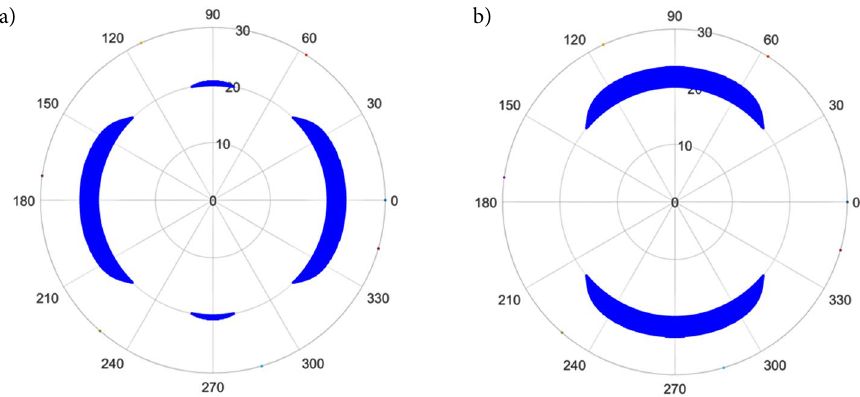
Figure 9. Failure contour for the strike-slip faulting stress regime: a) a = 0°, i = 0°; b) a = 90°, i = 90°